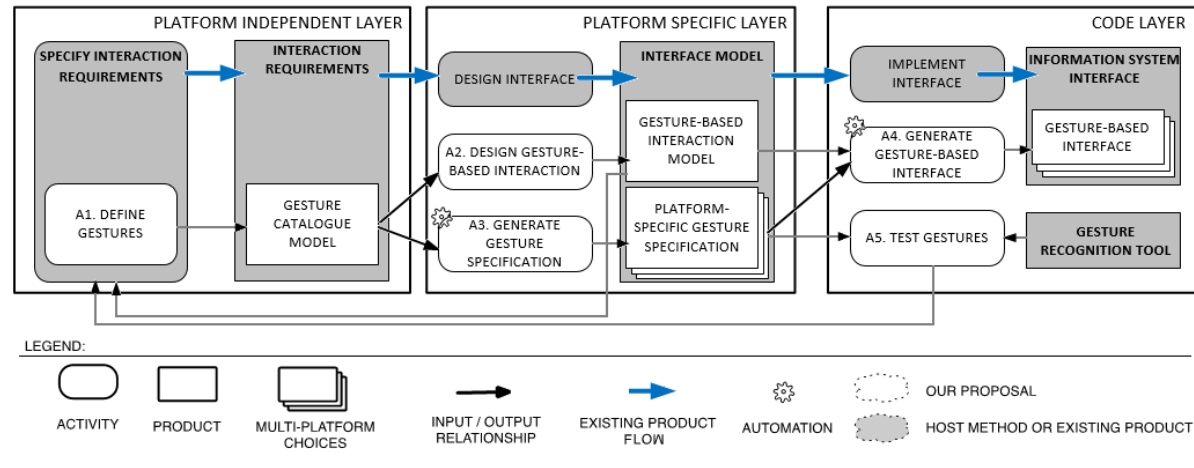
Figure 2 . gestUI method